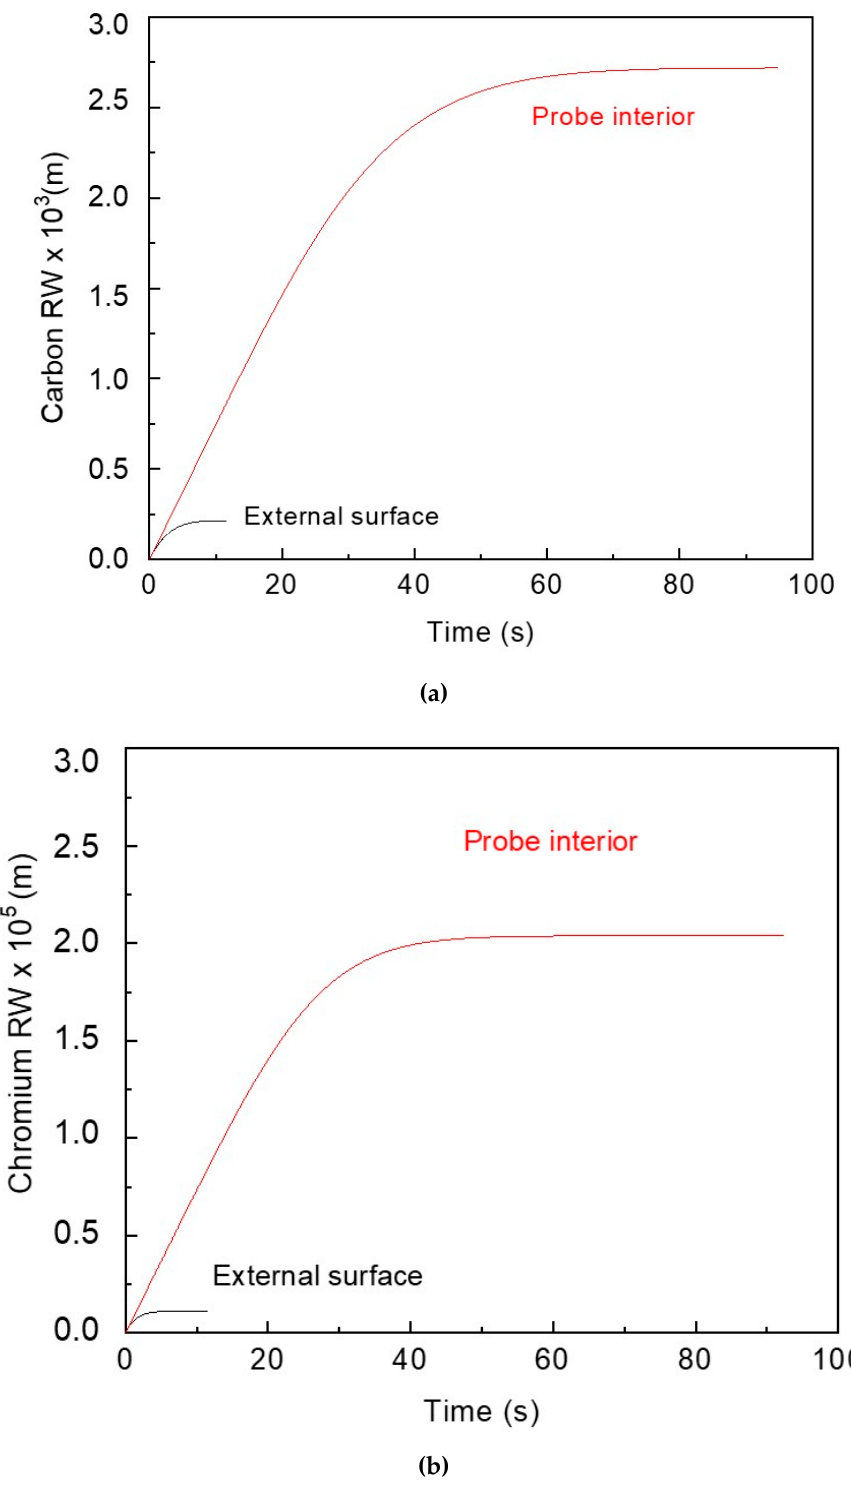
Figure 12. Random walk ( RW ) of C ( a ) and Cr ( b ) atoms vs. time at the surface and in the internal part of Charpy probes calculated on the basis of the trends reported in Figure 11.